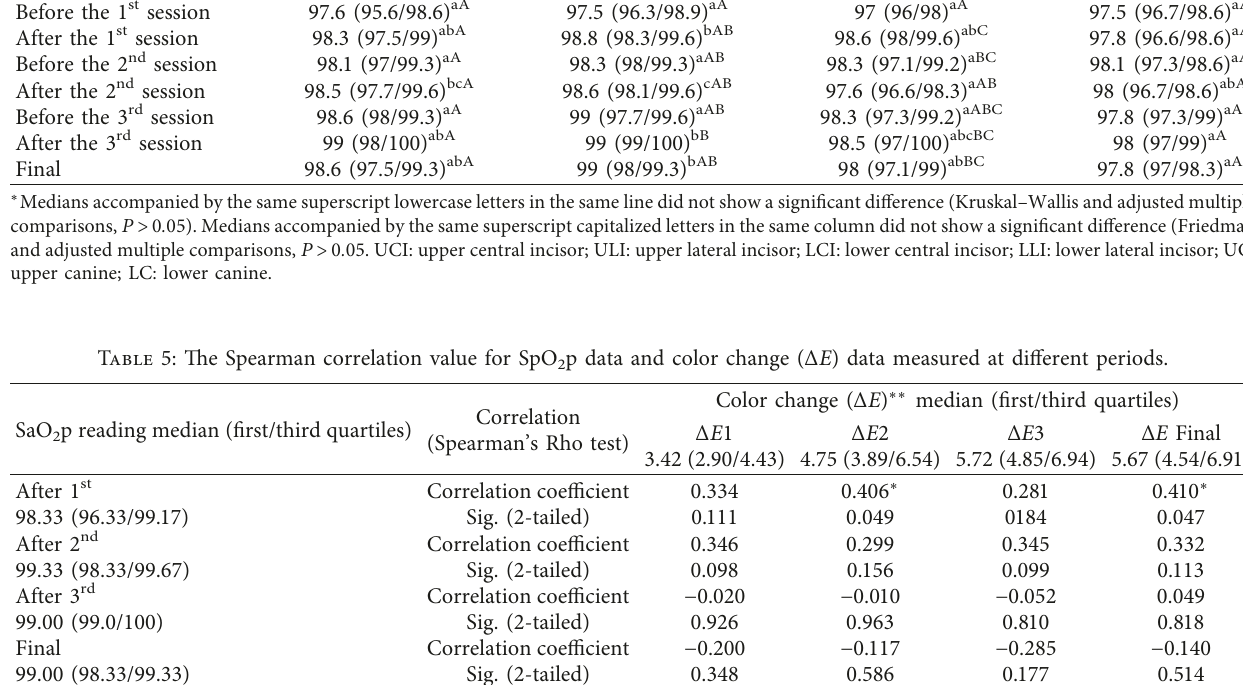
∗ Medians accompanied by the same superscript lowercase letters in the same line did not show a significant difference (Friedman, P > 0 . 05). Medians accompanied by the same superscript capitalized letters in the same column did not show a significant difference (Mann–Whitney U , P > 0 . 05). ϯ SpO 2 values measured on the patient’s finger. Table 3: Medians (first/third quartiles) of oxygen saturation levels measured at different periods of reading, regardless of the whitening gel used or the dental group evaluated ( n � 112, 14 patients) ∗ . Before 1 st ∗ Medians accompanied by the same superscript lowercase letters in the same line did not show a significant difference (Friedman, P > 0 . 05). Table 4: Medians (first/third quartiles) of oxygen saturation levels measured at different periods of reading for the different dental groups ∗ . UCI ( n � 28) Evaluation Before the 1 st session After the 1 st session Before the 3 rd session After the 3 rd session